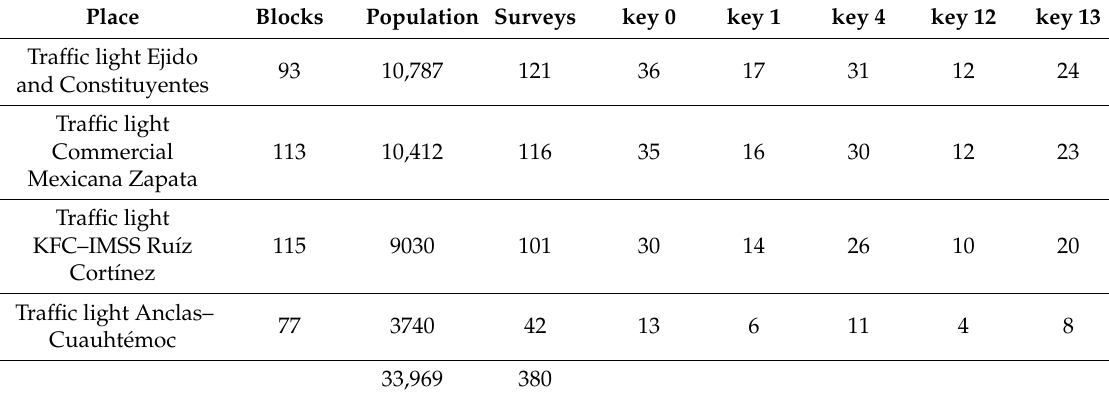
Table 5. A conglomerate study of the total surveys by